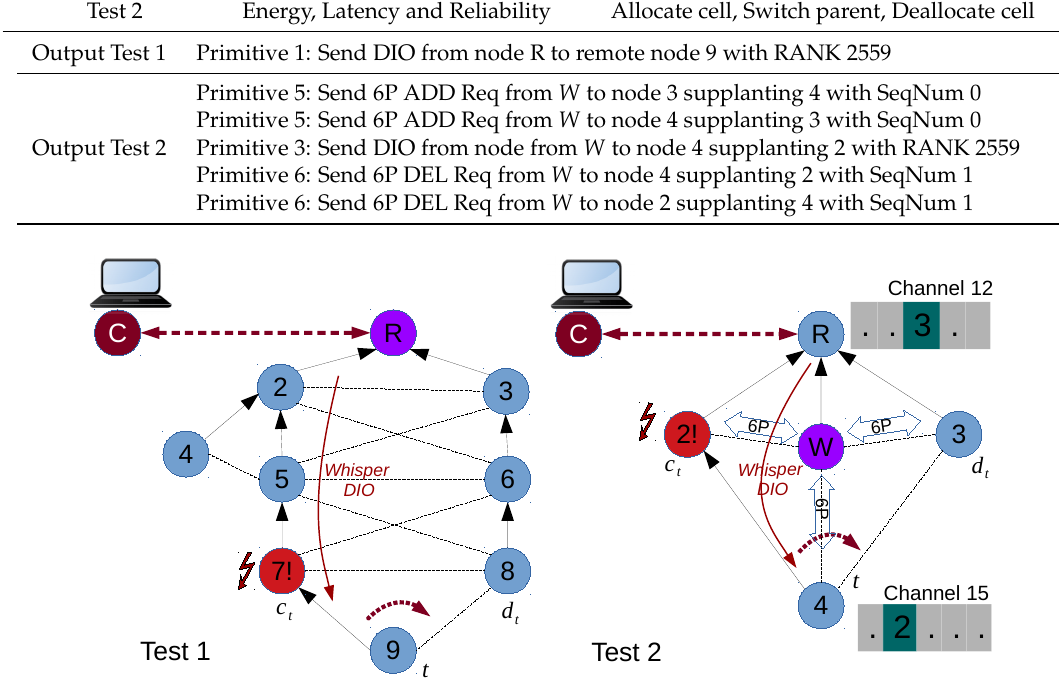
Figure 6. Topologies used for the two test use